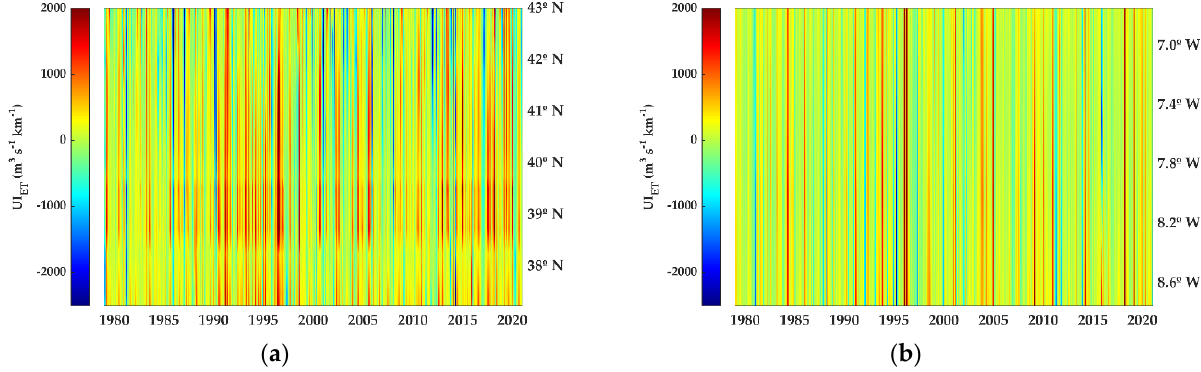
( d ) Figure 2. Percentage of upwelling-favourable conditions (occurrences) based on Ekman transport and SST indexes: ( a ) percentages of months with UI ET values higher than 100 m 3 s − 1 km − 1 , for each point; ( b ) percentages of months with UI SST values lower than − 0.6 °C, for each coastal point; ( c ) percentages of spatially averaged UI ET values higher than 100 m 3 s -1 km -1 , for each month of the year, on the west and south coasts; ( d ) percentages of spatially averaged UI SST values lower than − 0.6 °C, for each month of the year, on the west and south coasts. 3.2. Evolution of the Upwelling Index Based on Ekman Transport The temporal evolution of UI ET from 1979 to 2020 along the western and southern coasts is depicted in Figure 3. From this interannual evolution, a different behaviour be- tween UI ET for the western and southern coasts was observed, with more short-term vari-